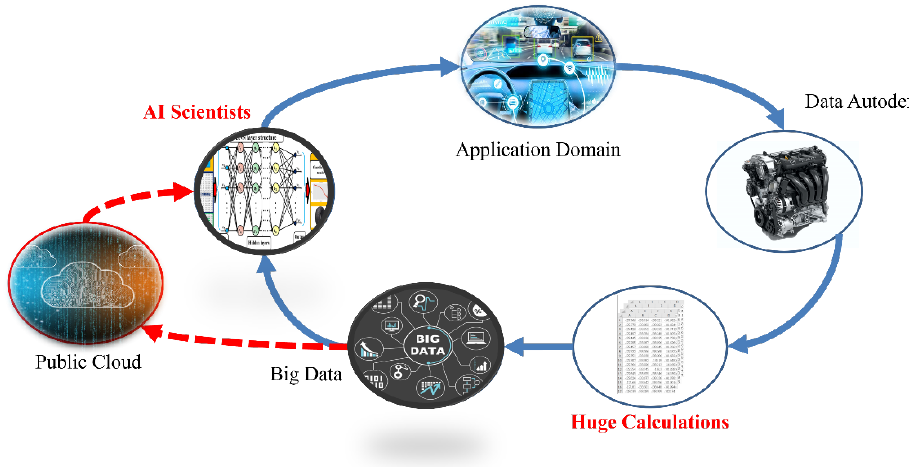
Figure 4. Schematic diagram of vehicle dynamic voiceprint recognition.